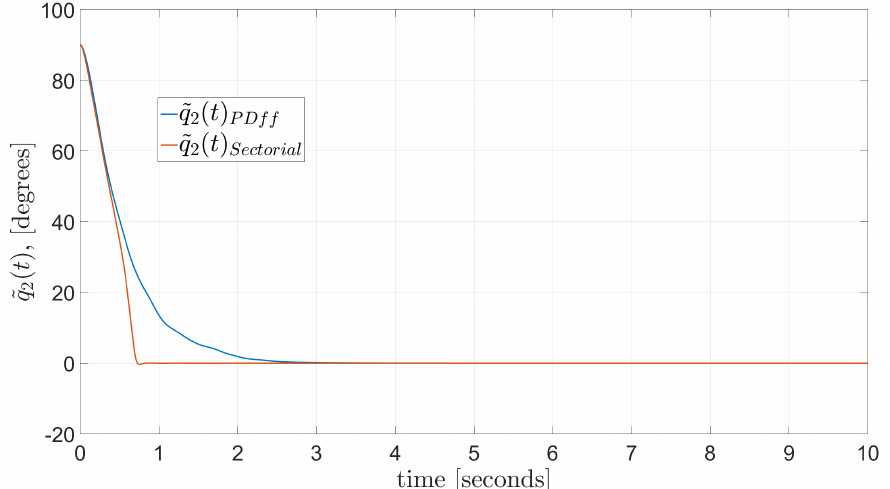
Figure 16. Angular position error for joint 2, without Coulomb